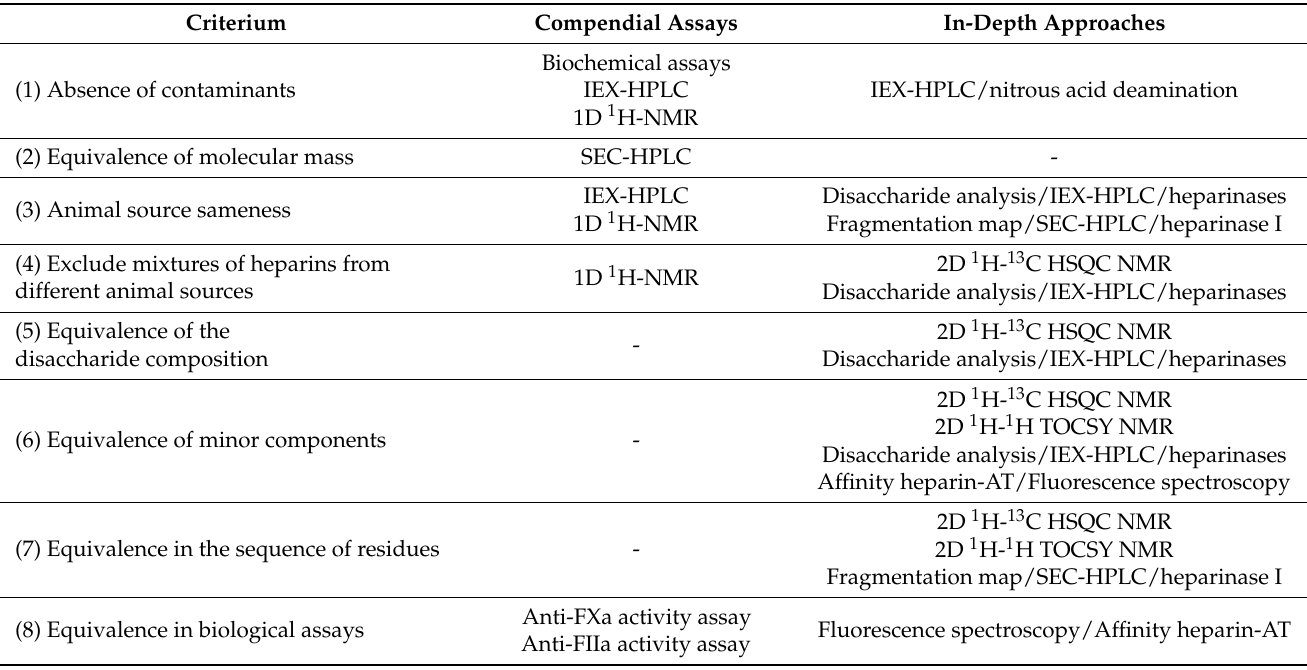
Table 1. Criteria and assays (compendial and in-depth approaches) proposed for performing compa- rability studies of pharmaceutical